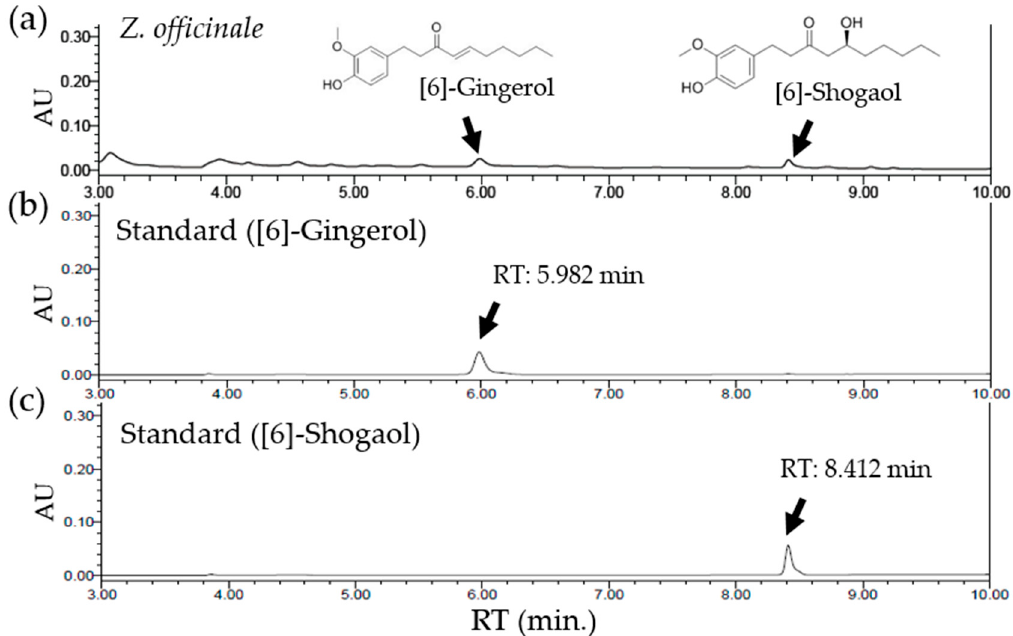
Figure 5. Quantification of chemicals in Z. officinale using HPLC. HPLC chromatograms of a water extract of Z. officinale ( a ) and of [6]-gingerol ( b ) and [6]-shogaol ( c ) as standards. Two peaks in ( a ) represent [6]-gingerol (5.982 min) and [6]-shogaol (8.412 min), sequentially. The standard ultraviolet detection wavelength was set at 230 nm. The X -axis reports the retention time (RT), and the Y -axis the absorbance unit (AU).